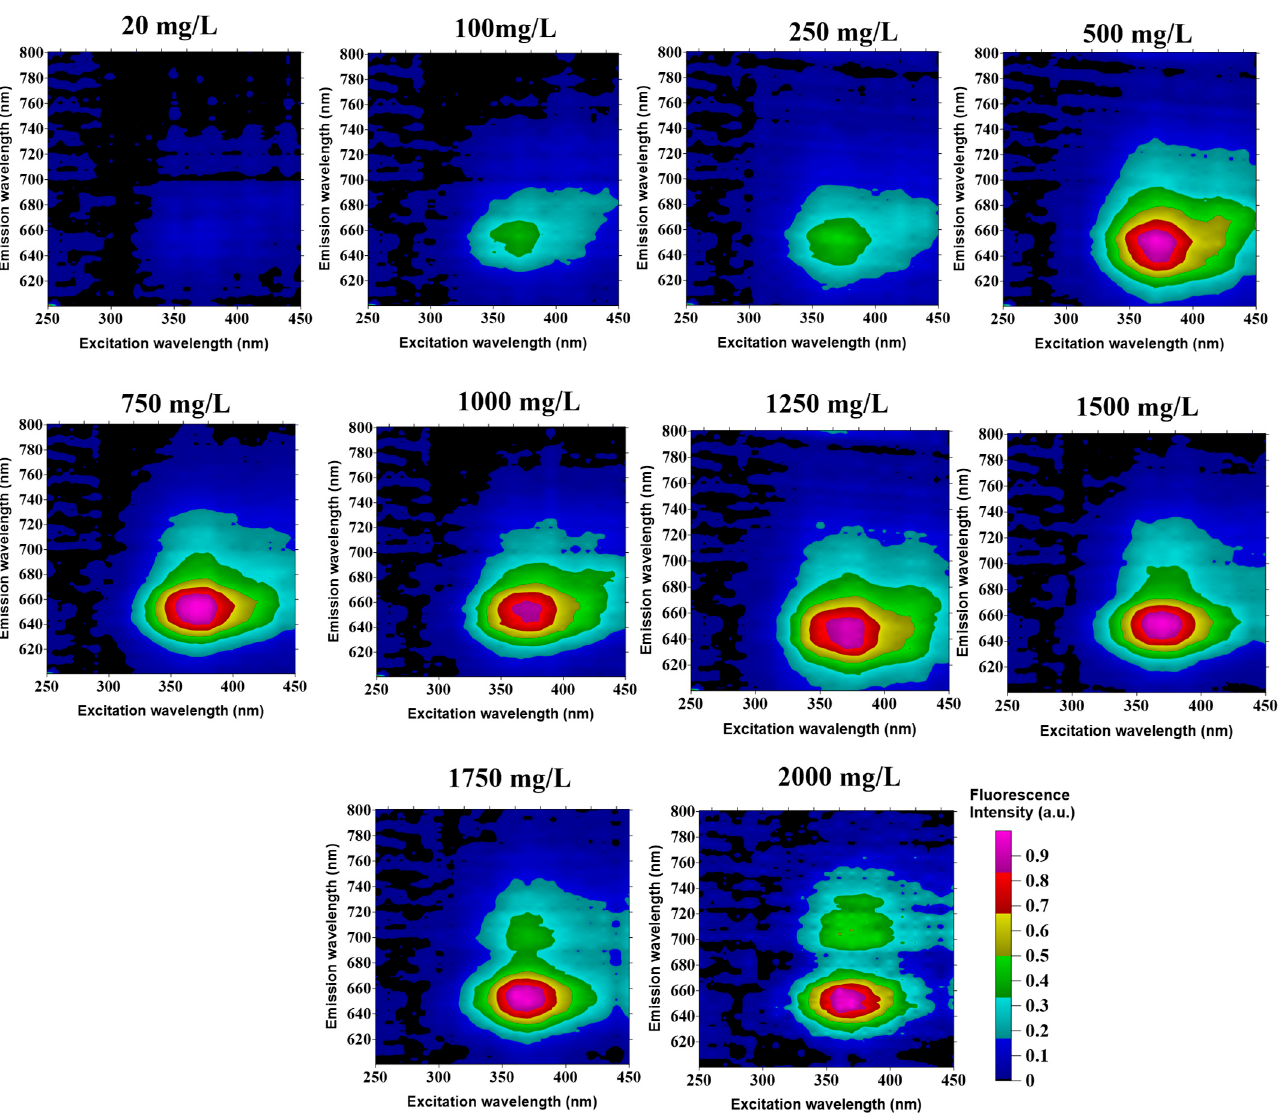
Figure 4. Algal pigment EEMs of commercialized AZTEC Spirulina at varying concentrations.